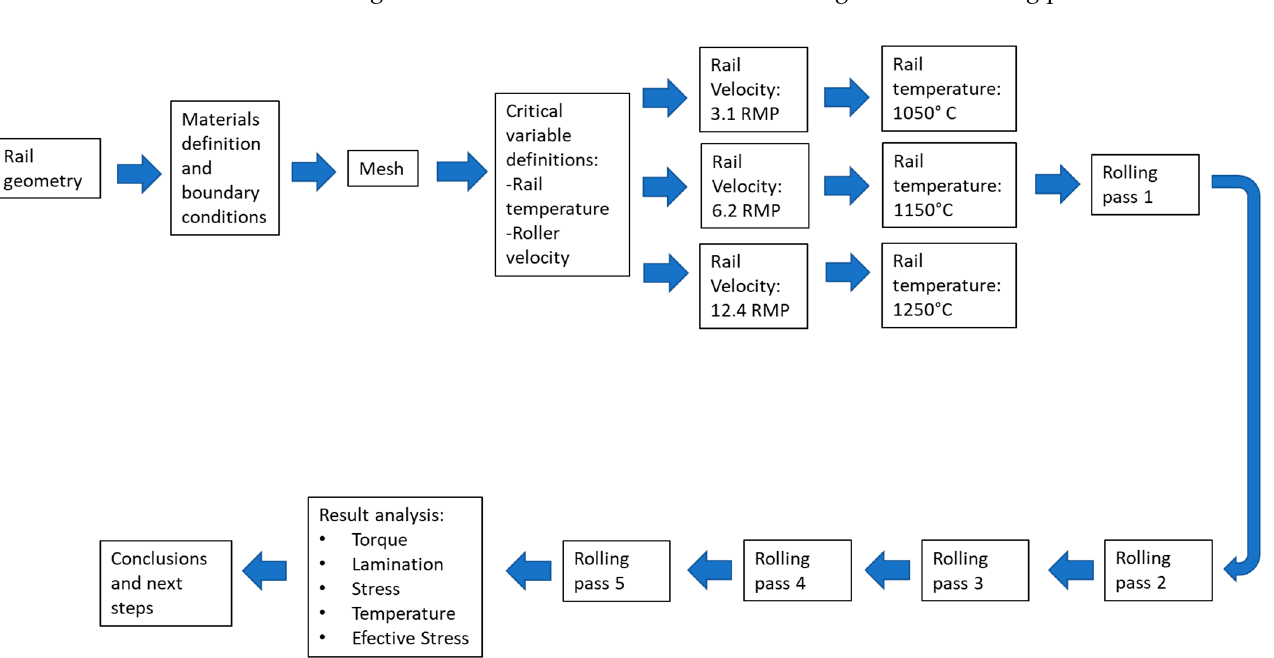
Figure 7. Upper rail experimentation flowchart.